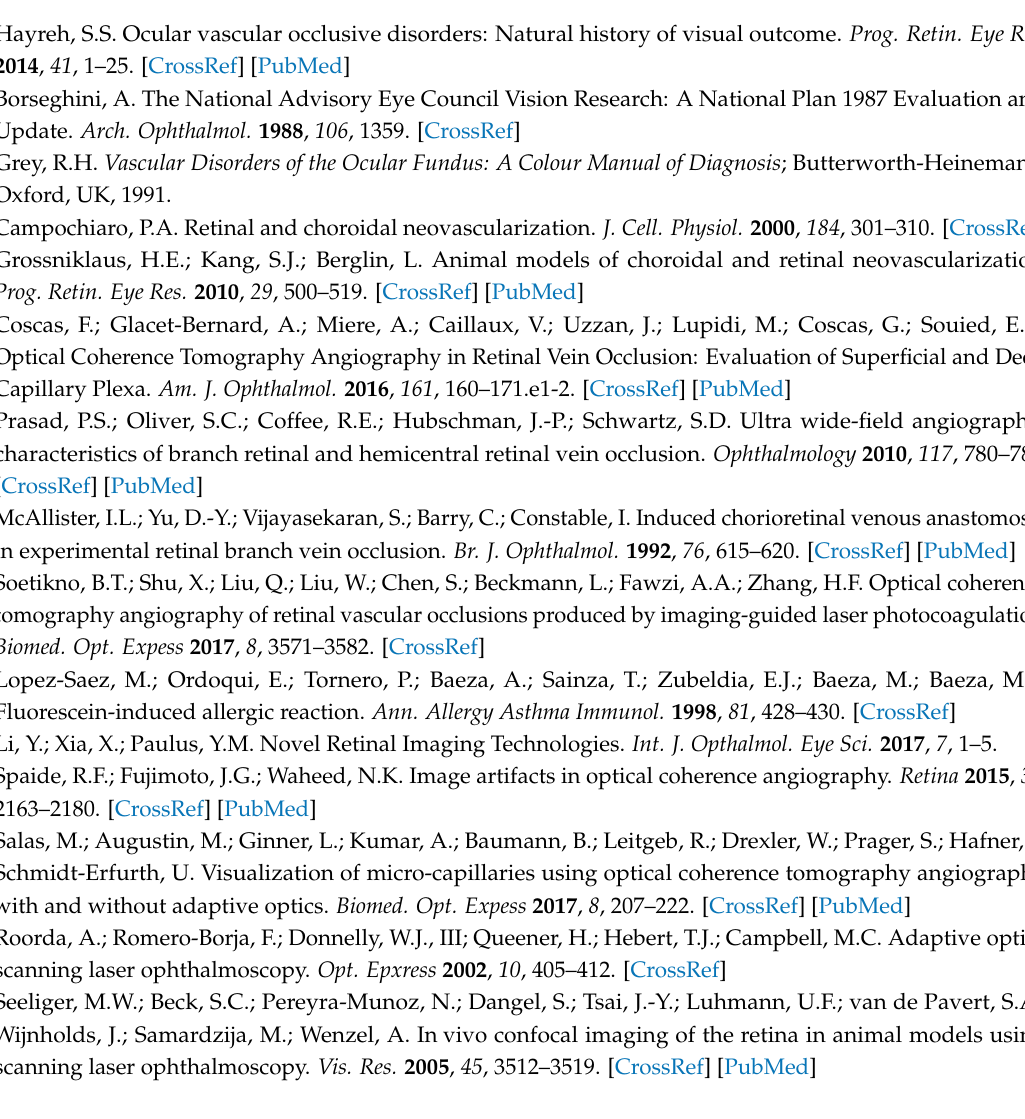
Figure A2. Color fundus photography of the retina before and after VEGF injection. The white rectangles indicate the selected scanning regions for PAM whereas the white dotted lines represent the selected scanning regions for OCT.